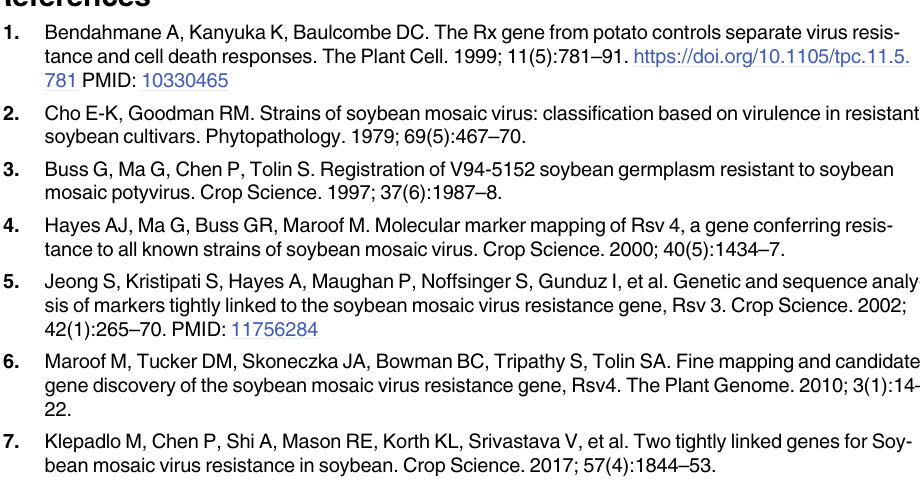
S5 Table. Putative TF-module interactions supported by orthologous interactions found in A . thaliana . S6 Table. Motif enrichment analysis of co-expression modules and transcription factors recognizing motif